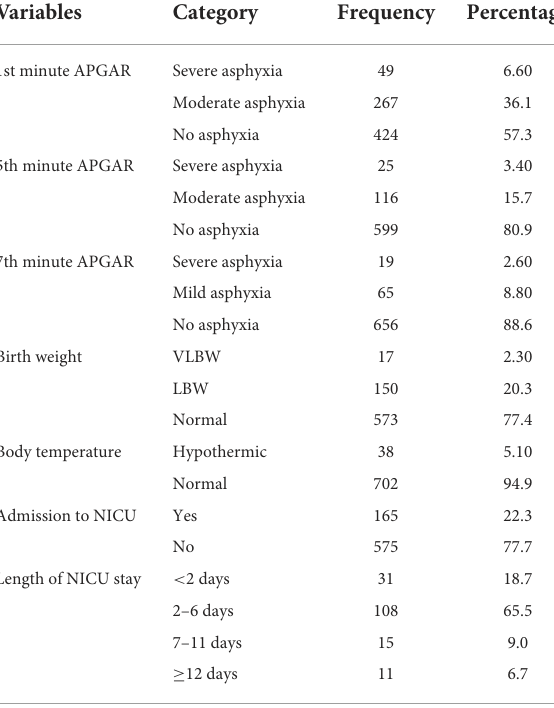
TABLE 3 Pregnancy-related maternal health characteristics of women in the North Shewa zone, Oromia region, Ethiopia, 2021. Variables Category Frequency Percentage Prenatal hemorrhage